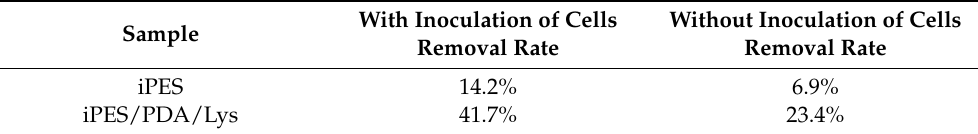
Table 3. Bilirubin removal rate of the membranes from plasma of patients with